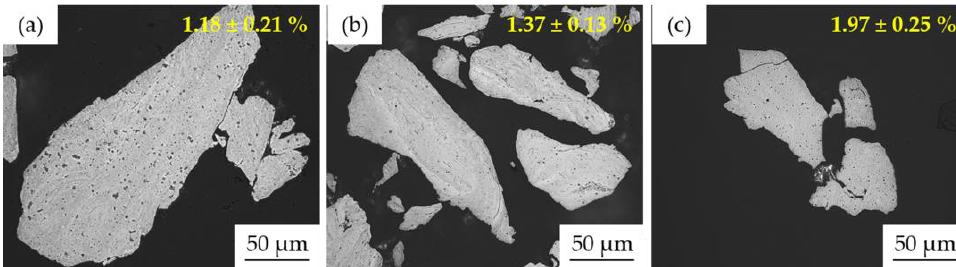
Figure 3. LM micrographs of the MA powder alloys with marked surface porosity determined using the threshold method: ( a ) Mn15Al5, ( b ) Mn10Al10, ( c )